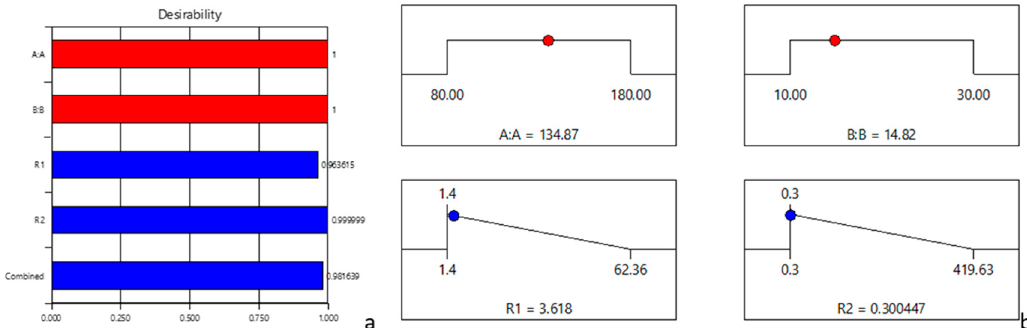
Figure 4. Chart of individual desirability functions. ( a )- desirability chart; ( b )– desirability solution; AA – temperature; BB – time; R1 – HMF; R2 – ACR.